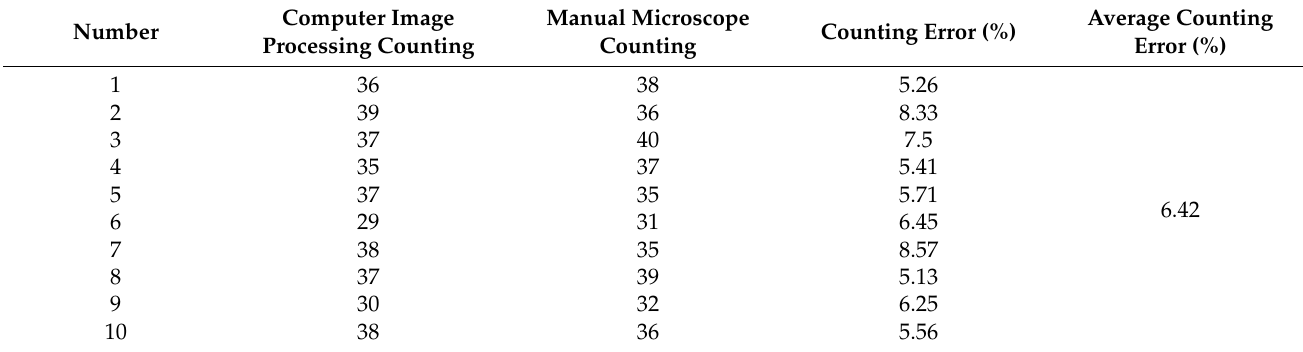
Table 2. Results of manual counting and diffraction image reconstruction recognition counting in the microscope field.